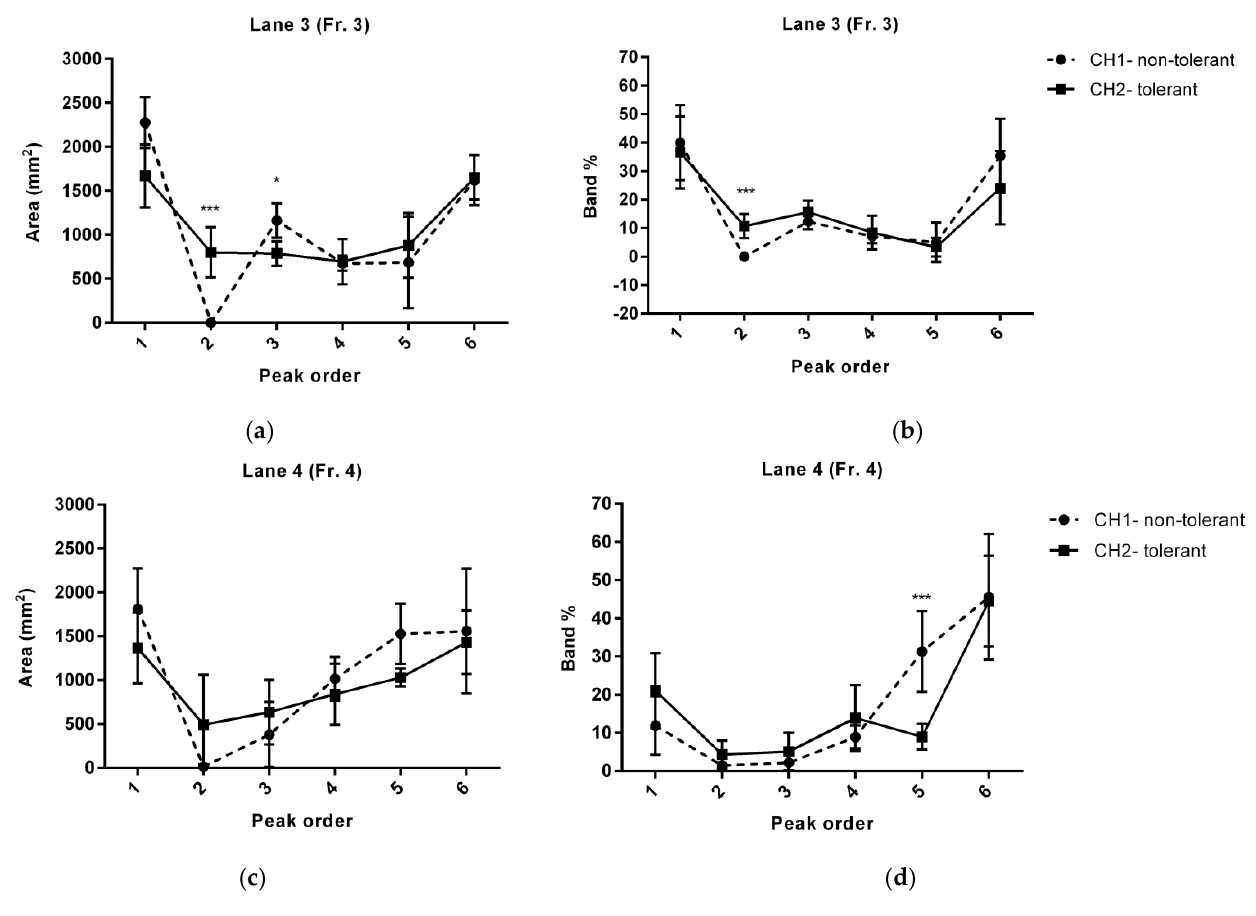
Figure 5. Lane profiles of protein peaks from fractions 3 and 4 after separation with sodium dodecyl sulphate–polyacrylamide gel electrophoresis. ( a ) Peak area (mm 2 ) and ( b ) percentage of the total area of the peaks in the lane (band %) of proteins derived from fractions 3 of tolerant (CH1) and non-tolerant (CH2) secretomes. ( c ) Peak area (mm 2 ) and ( d ) percentage of the total area of the peaks in the lane (band %) of proteins derived from fractions 4 of tolerant (CH1) and non-tolerant (CH2) secretomes. The data are presented as the mean ± standard deviation (* p < 0.05; *** p <0.001). Fr., protein fraction separated by native polyacrylamide gel electrophoresis; CH, fluorescence channel of tolerant/non-tolerant proteins.